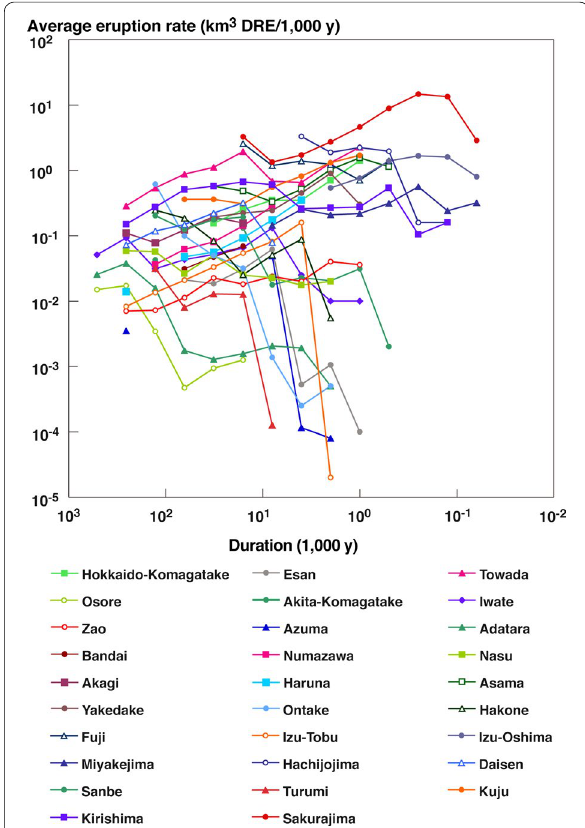
Fig. 2 Average magma eruption rate versus duration when it dated back to from last eruption for 29 volcanoes. The average rates are calculated from dataset of volume and age for Quaternary volcanoes in Japan, complied by Yamamoto (2015)